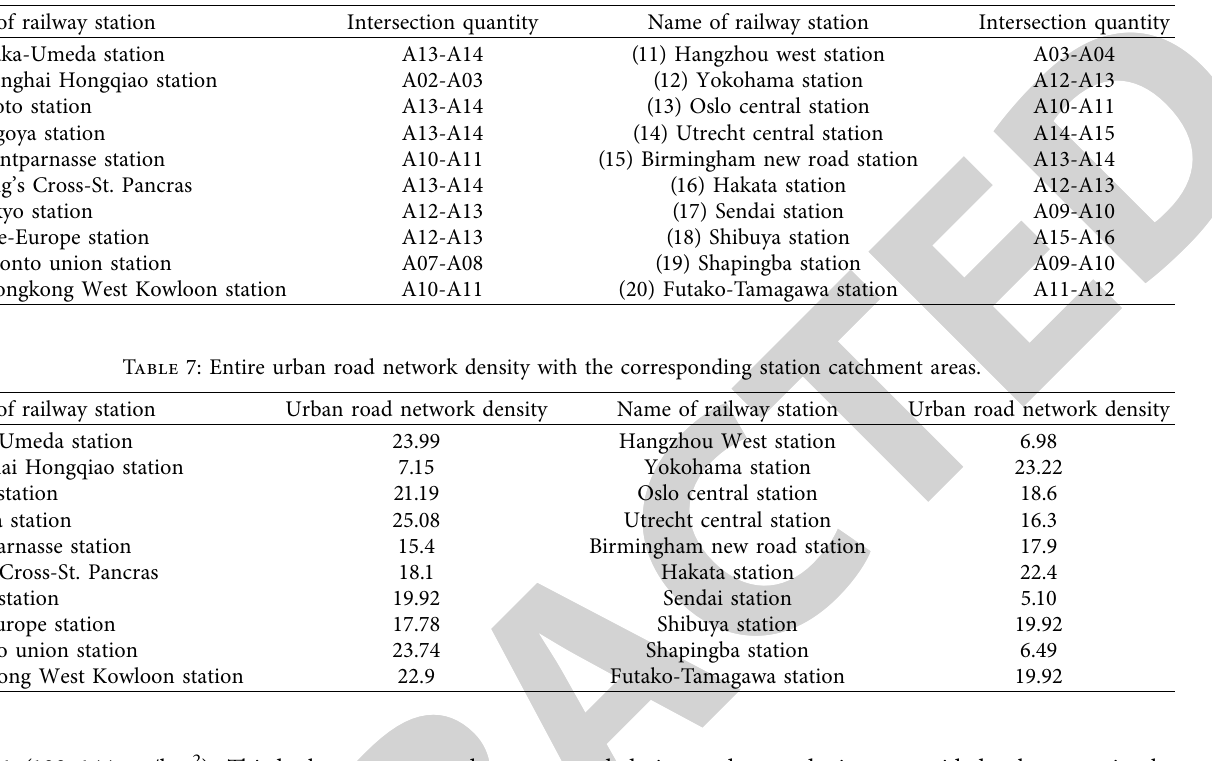
Table 6: The intersection quantity clustering.